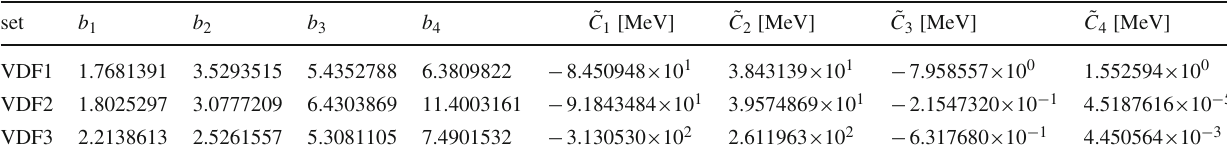
Table 3 Parameter sets corresponding to the VDF EOSs reproducing nuclar matter characteristics listed in Table 1 set b 1 b 2 b 3 b 4 ˜ C 1